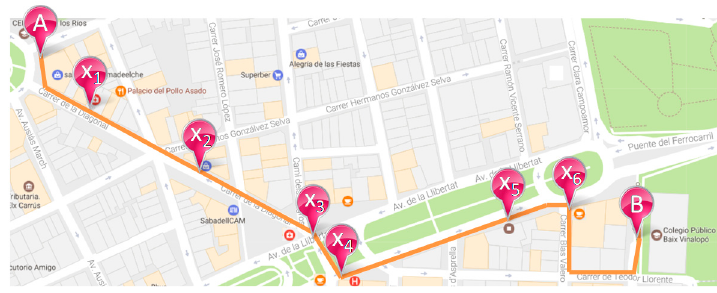
Figure 6. Route decomposition example.